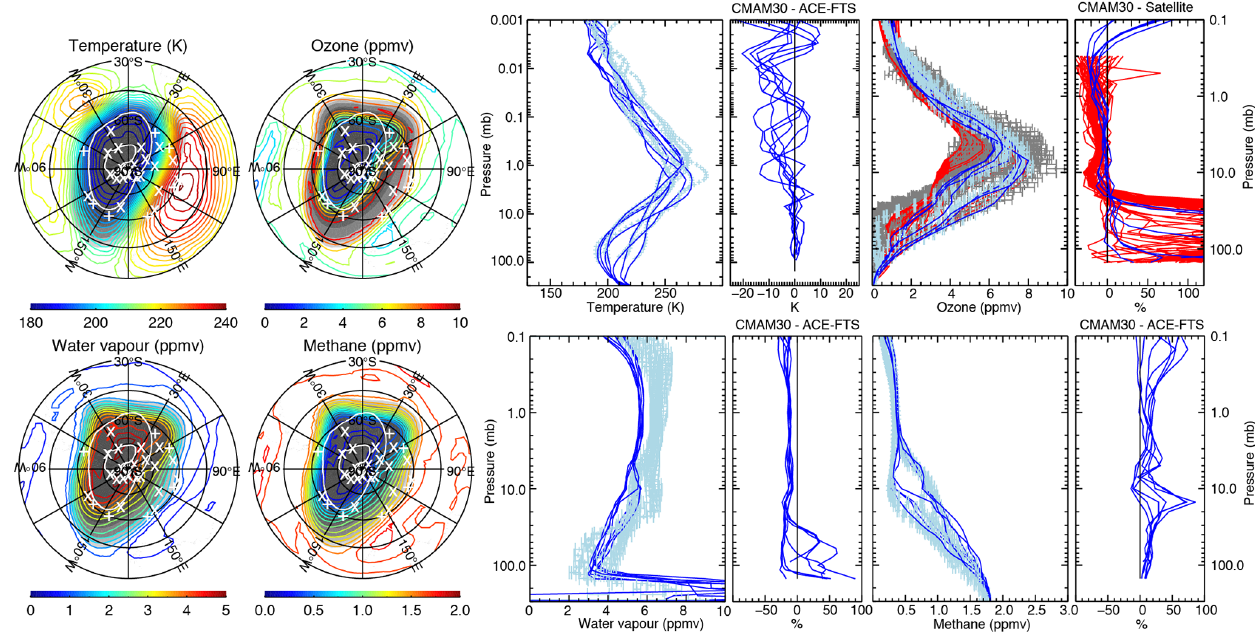
Figure 12. Same as Fig. 11 but for 25 September 2006. OSIRIS measurements are grey, with CMAM30 coincident profiles in red and differences with respect to OSIRIS in red. Locations of each profile are marked on the isentropic plots for ACE-FTS profiles (white crosses) and for OSIRIS (white